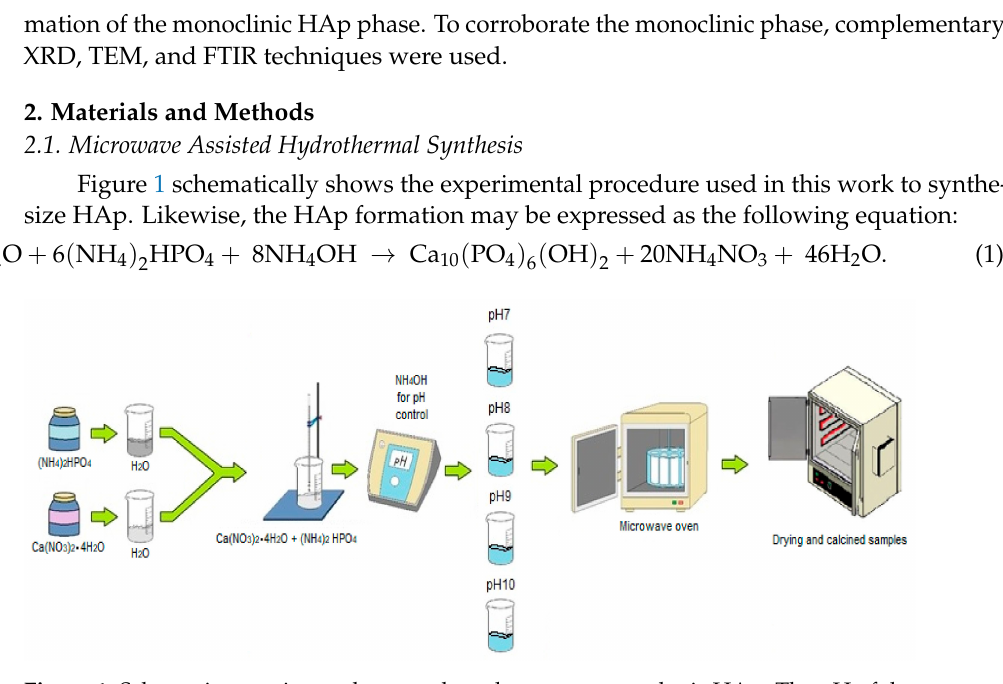
Figure 1. Schematic experimental protocol used to prepare synthetic HAp. The pH of the aqueous precursors’ solutions was adjusted prior to performing the chemical reaction inside the microwave